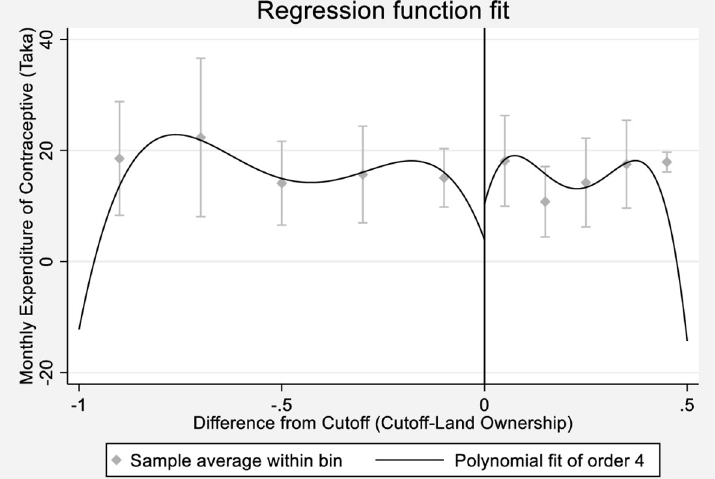
Fig 2. Discontinuity in monthly contraceptive expenditure around the cutoff. Notes : The horizontal axis is the difference from the cutoff in acres, and the vertical axis shows monthly contraceptive expenditure. Every dot in the graph represents the sample average within bin, whereas every line represents the fourth order polynomial approximation of the outcome variable. The vertical line in the figure indicates 0 acres from the cutoff.